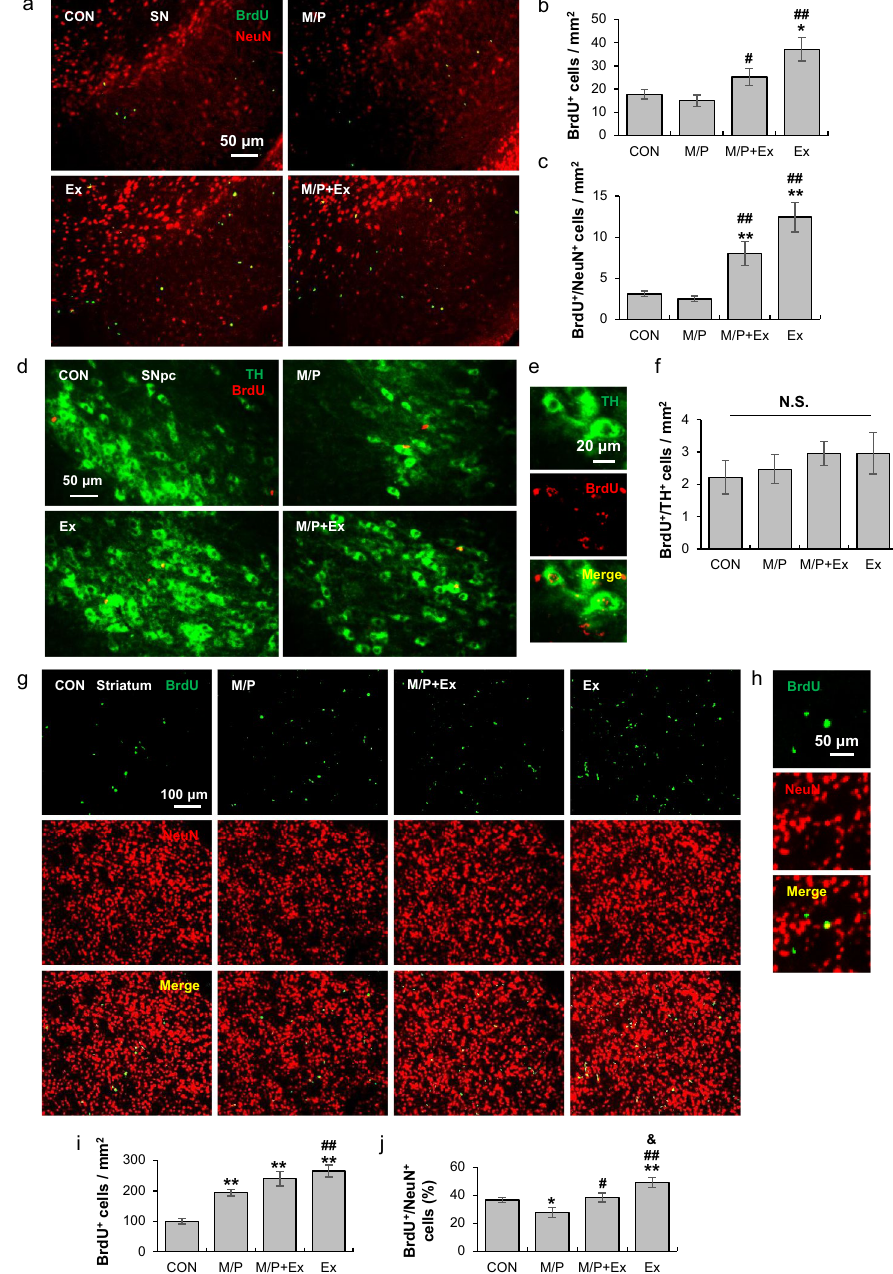
Figure 6. Rotarod walking exercise enhanced the neuronal commitment of the SN and the striatum areas of M/P-treated mice. ( a ) Photomicrographs of the double fluorescent staining of dorsal SN BrdU + and NeuN + cells (CON, N = 8; M/P, N = 9; M/P + Ex, N = 9; Ex, N = 8, 200 × of magnification). ( b ) Quantification of the fluorescent intensity of SN BrdU + cells showing that exercise increased the number of BrdU + cells, regardless of MPTP treatment. ( c ) Quantification of the fluorescent staining of SN BrdU + /NeuN + cells showing that exercise increased the number of BrdU + /NeuN + cells, regardless of MPTP treatment. ( d ) Photomicrographs of the double fluorescent staining of SNpc BrdU + and TH + cells (N = 9 in each group, 200 × of magnification) showing no difference in the number of BrdU + /TH + cells between groups. ( e ) Representative photomicrograph of the high magnitude of SNpc BrdU + /TH + cells (400 × of magnification). ( f ) Quantification of the fluorescent staining of SNpc BrdU + /TH + cells. ( g ) Photomicrographs of the double fluorescent staining of striatal BrdU + and NeuN + cells (N = 8 in each group, 200 × of magnification). ( h ) Representative photomicrograph of the high magnitude of striatal BrdU + / NeuN + cells (400 × of magnification). ( i ) Quantification of the fluorescent intensity of striatal BrdU + cells showing that M/P and exercise increased the number of BrdU + cells. ( j ) Quantification of the fluorescent staining of striatal BrdU + /NeuN + cells showing that exercise restored the M/P-induced decrease in BrdU + /NeuN + cells. Data are presented as mean ± SEM. *p < 0.05, vs. CON; **p < 0.01, vs. CON; # p < 0.05, vs. M/P; ## p < 0.01, vs. M/P; & p < 0.05, vs M/P + Ex. SNpc, substantia nigra par